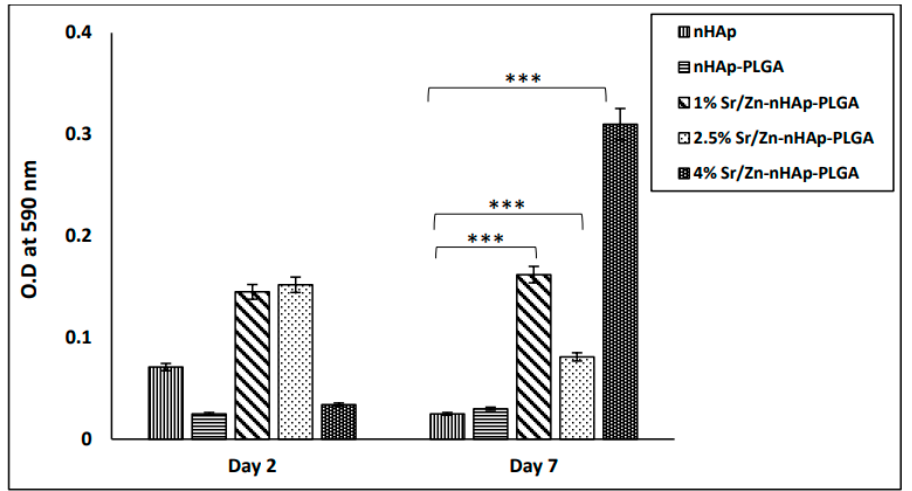
Figure 6. MTT assay for osteoblasts cultured for 2 and 7 days on different scaffolds: (nHAp, nHAp ‐ PLGA, 1% Zn/Sr ‐ nHAp ‐ PLGA, 2.5% Zn/Sr ‐ nHAp ‐ PLGA, and 4% Zn/Sr ‐ nHAp ‐ PLGA). *** p ≤ 0.001 nHAp-PLGA, 1% Zn/Sr-nHAp-PLGA, 2.5% Zn/Sr-nHAp-PLGA, and 4%